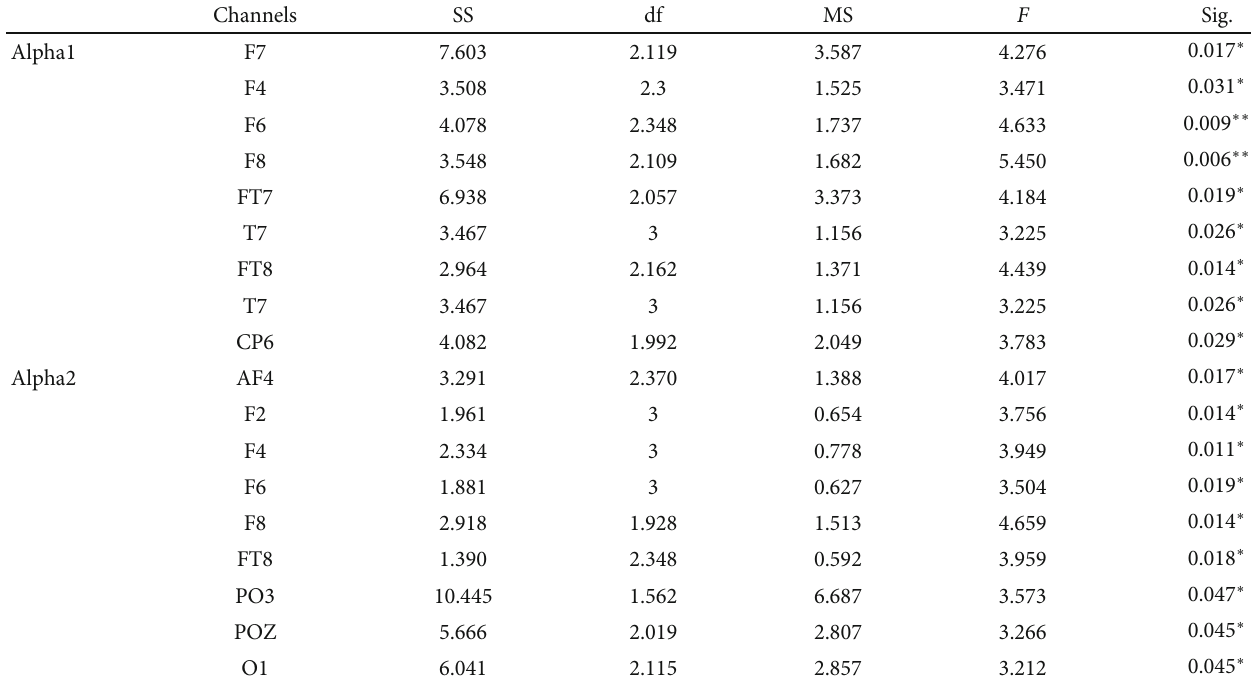
Table 2: Repeated measures ANOVA results of channels with statistical di ff erences.